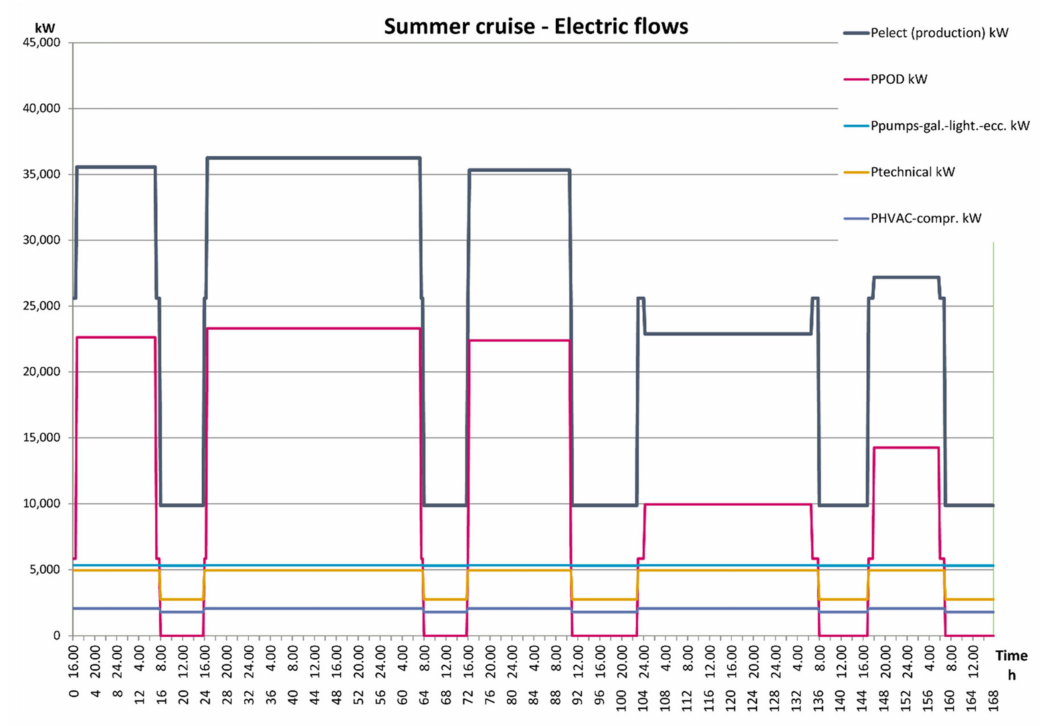
Figure 2. Electrical demand during the summer